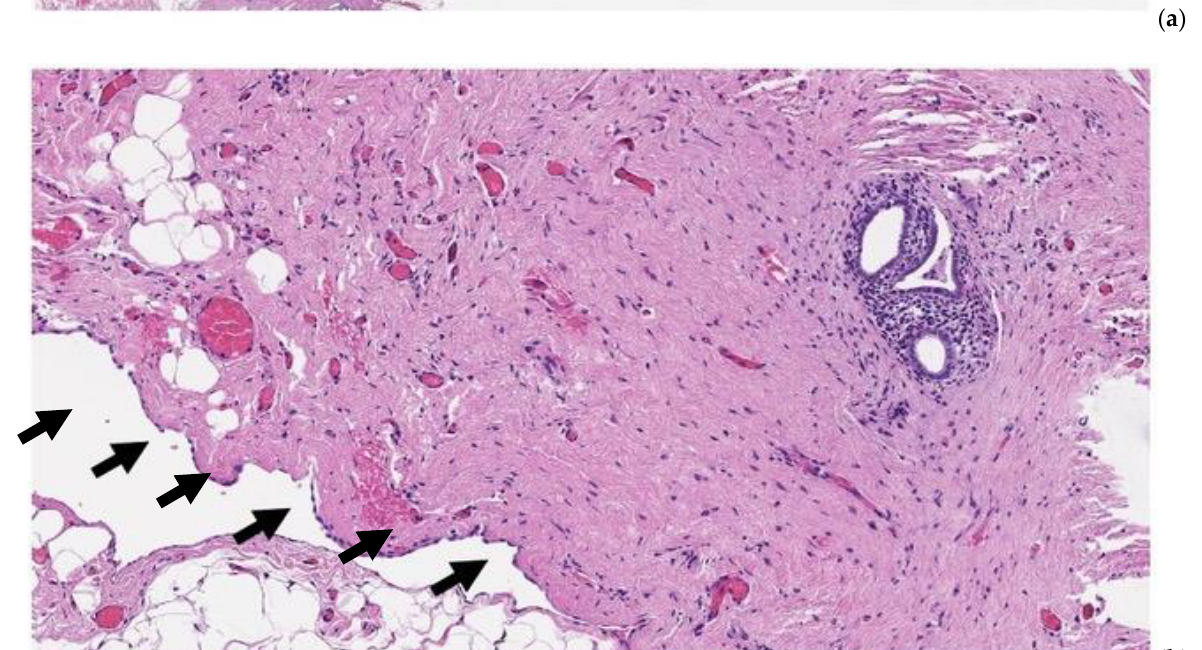
Figure 4. Pathology specimen after full-thickness omphalectomy for umbilical endometriosis. At scanning magnification (( a ), hematoxylin-eosin, 10×), foci of endometriosis are apparent, spanning from the deeper tissues of the abdominal wall throughout the dermal layer (left to right). At higher magnification (( b ), hematoxylin-eosin, 100×), endometrial glands are identified in the stroma underlying the parietal peritoneal mesothelial surface (arrows).